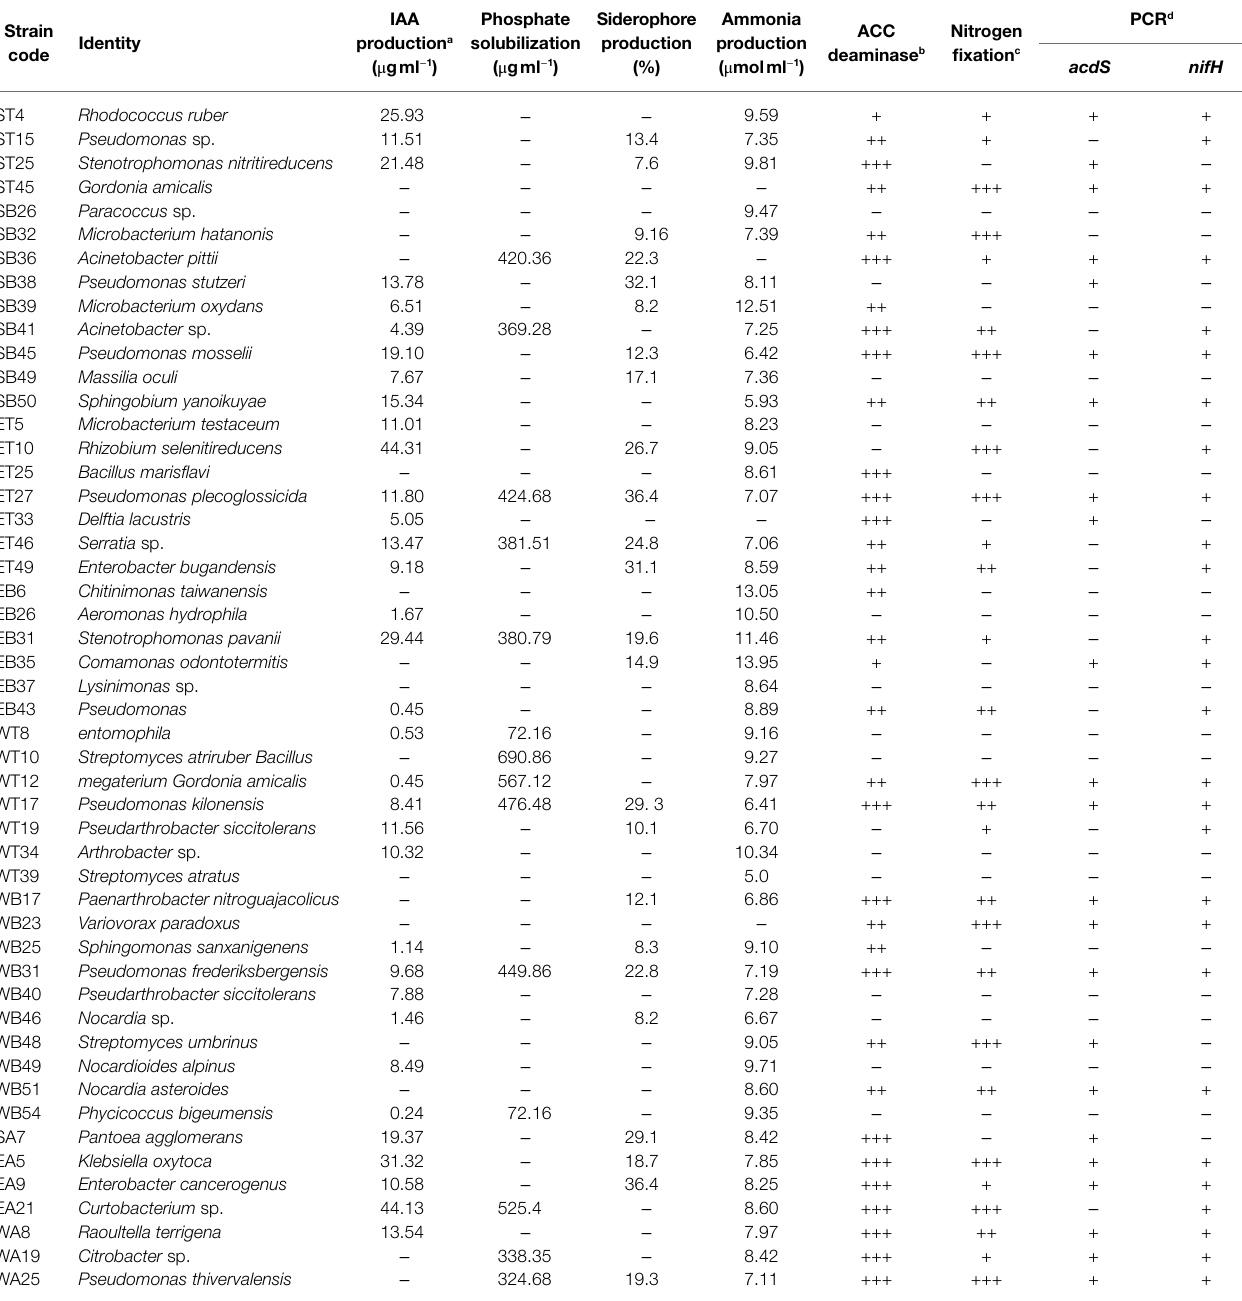
TABLE 2 | Screening of selected bacterial strains for PGP